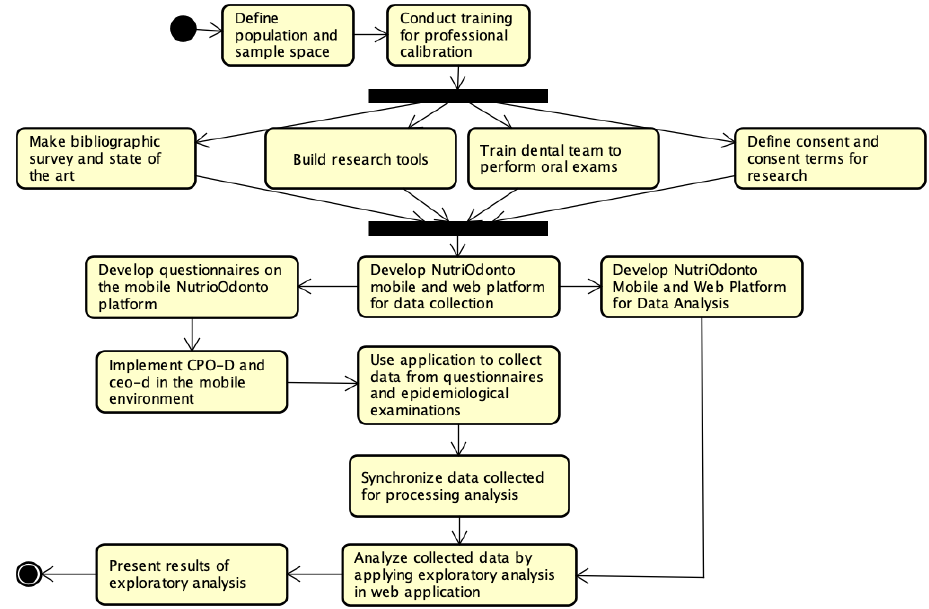
Figure 1. Steps to the development of the NutriOdonto environment. Source: Author’s own